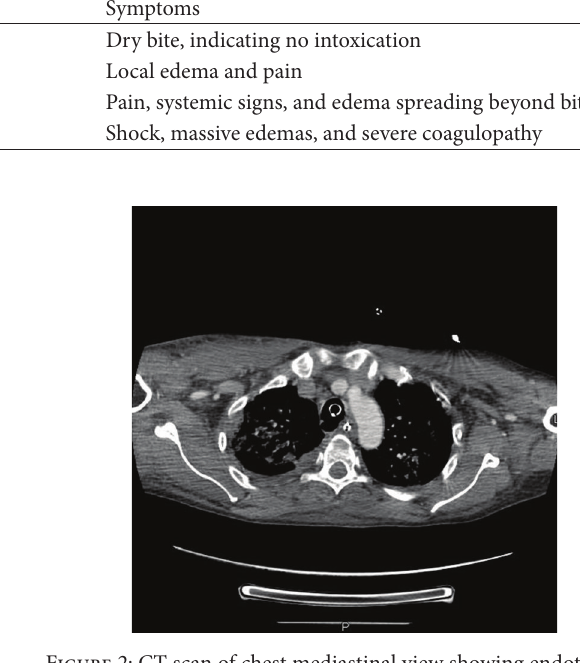
Figure 2: CT scan of chest mediastinal view showing endotracheal tube in trachea and also showing weakness in the posterior mem- branous wall of trachea.